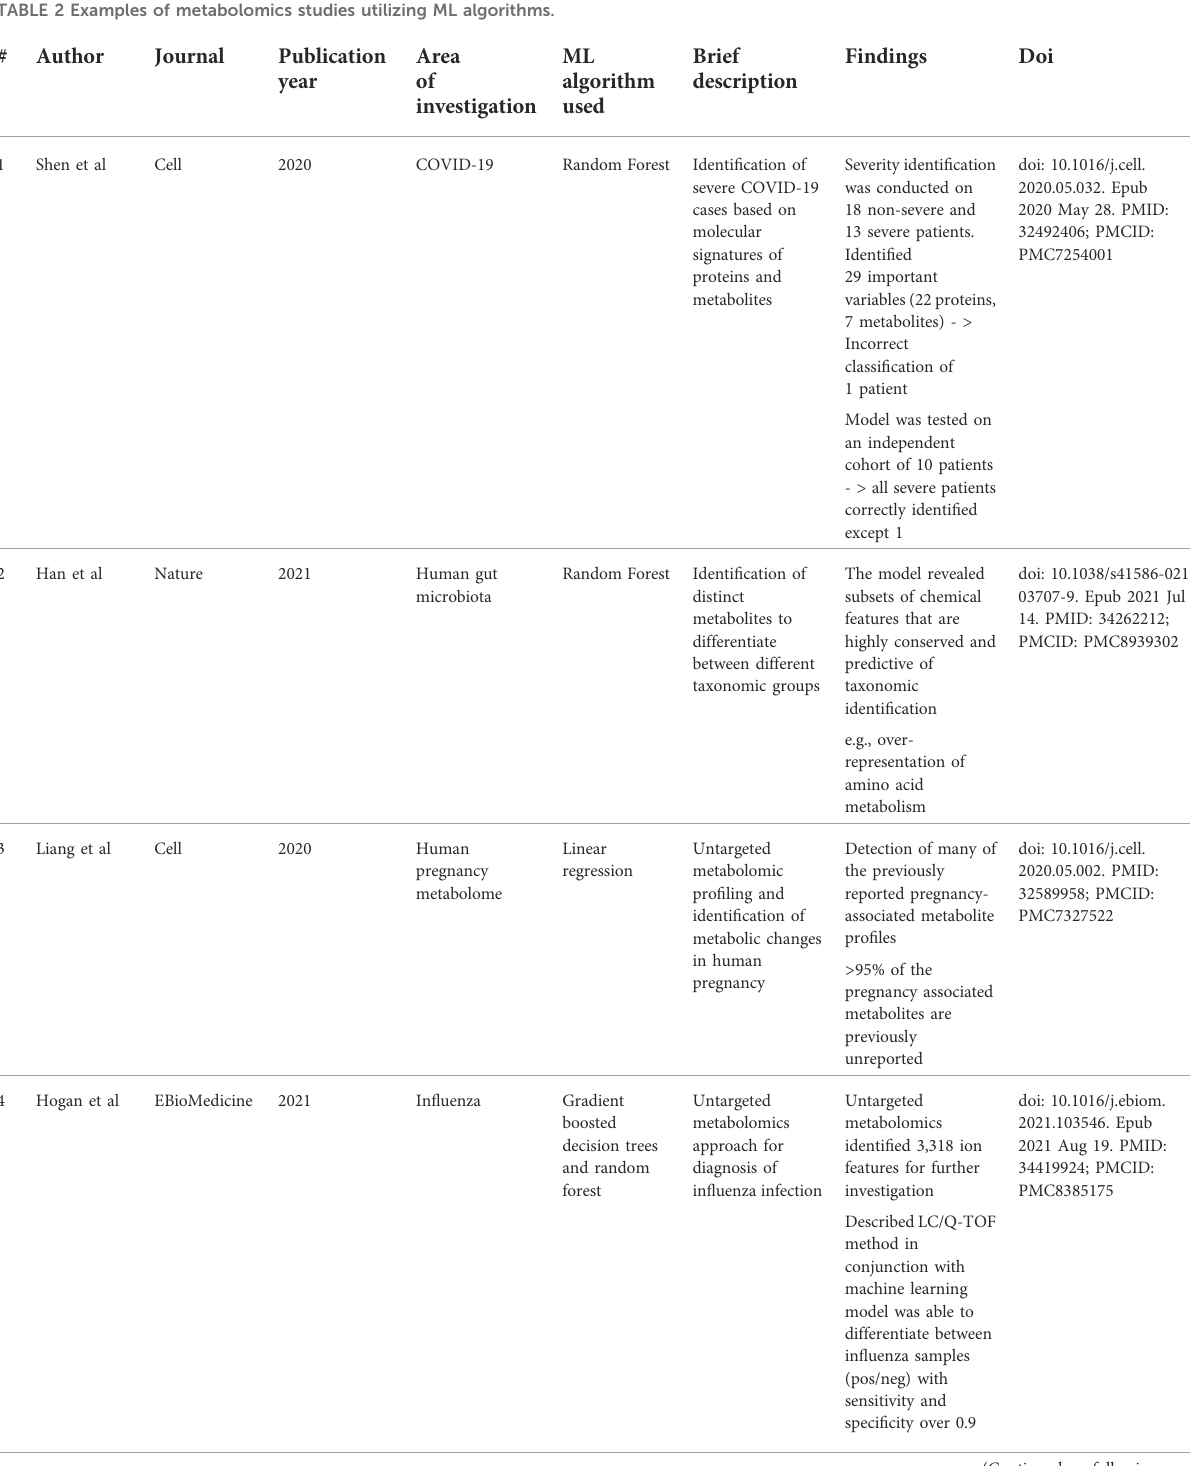
TABLE 2 Examples of metabolomics studies utilizing ML